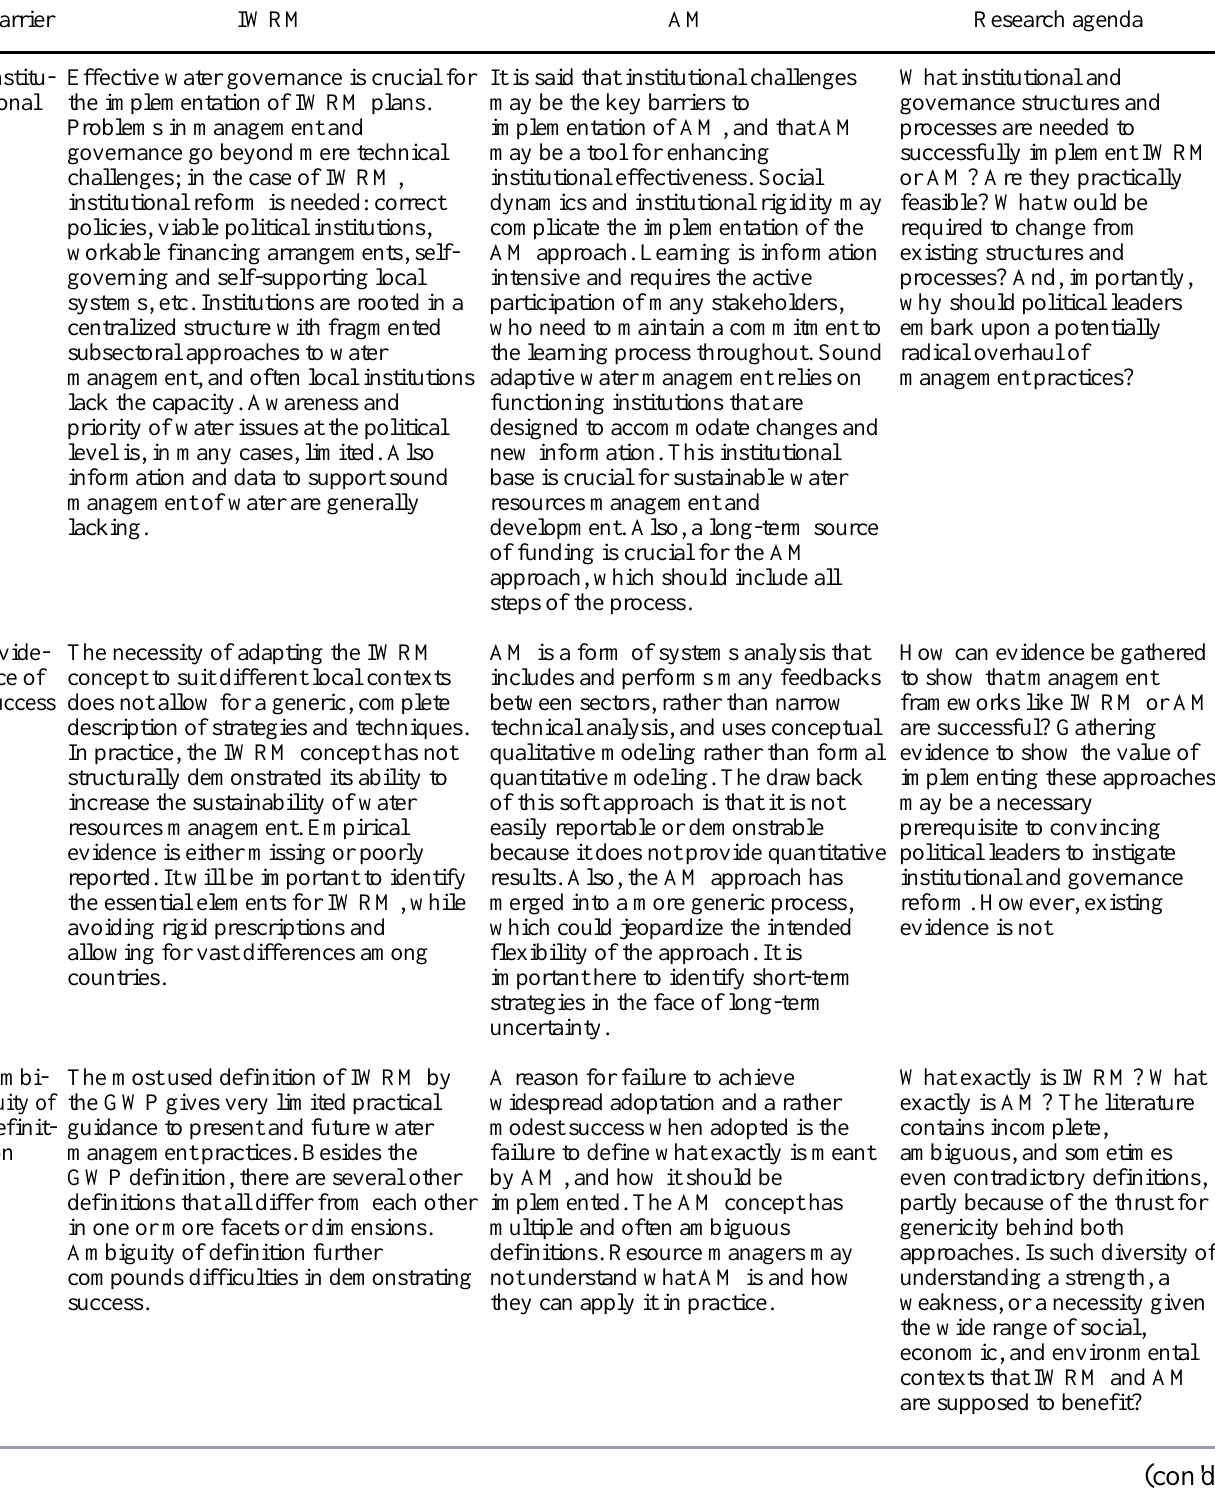
Table 2. Major barriers to the implementation of IWRM and AM concepts